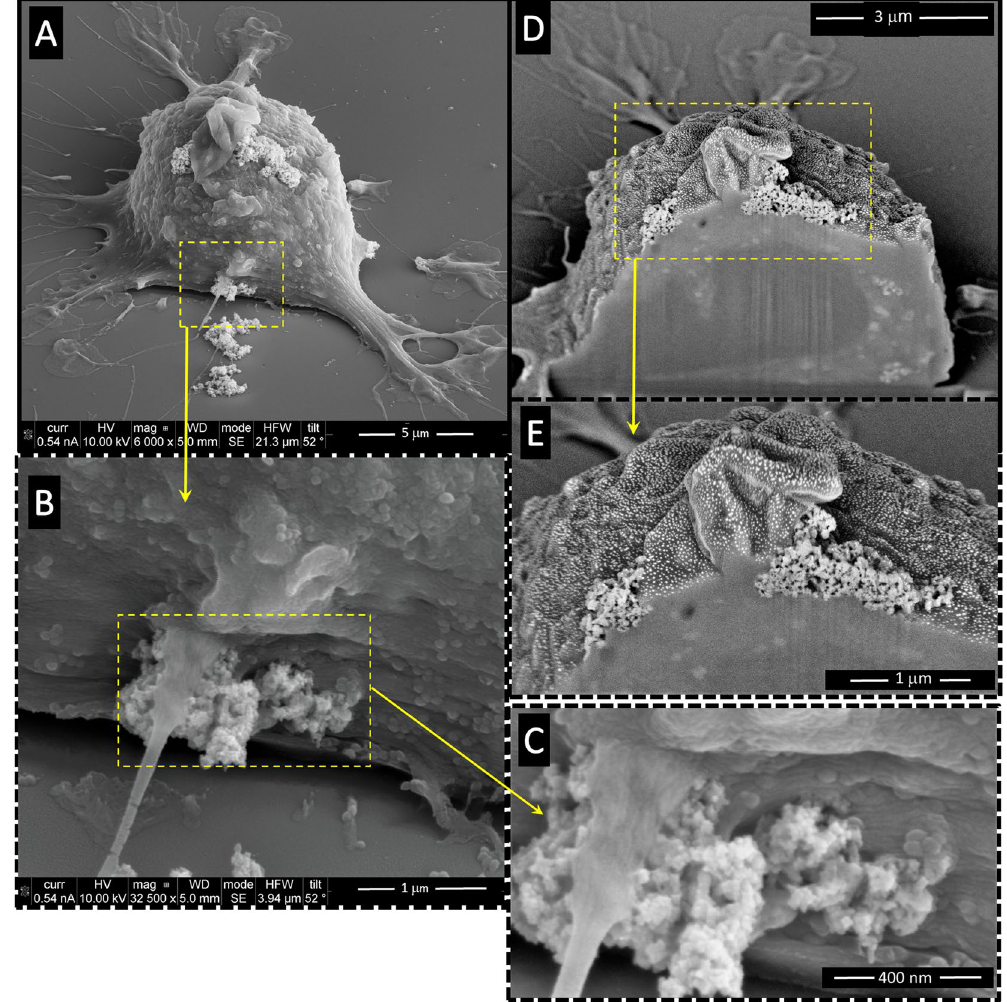
Figure 6. SEM-FIB (Dual–Beam) images of BV2 cells incubated with PAA-MNPs (50 μ g/ml, ≈ 12 pg/cell) showing several clusters pinned at different points of the cell membrane ( A , B and C ). Cross-sectioning of one cell at one cluster location ( D and E ) showed clearly the insertion of the agglomerates through the cell membrane and penetration into the cytoplasm ( C and D ).